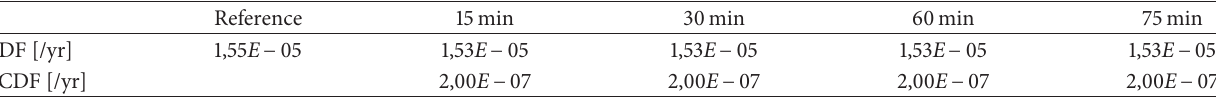
Table 7: Obtained CDF and Δ CDF for different time delays.